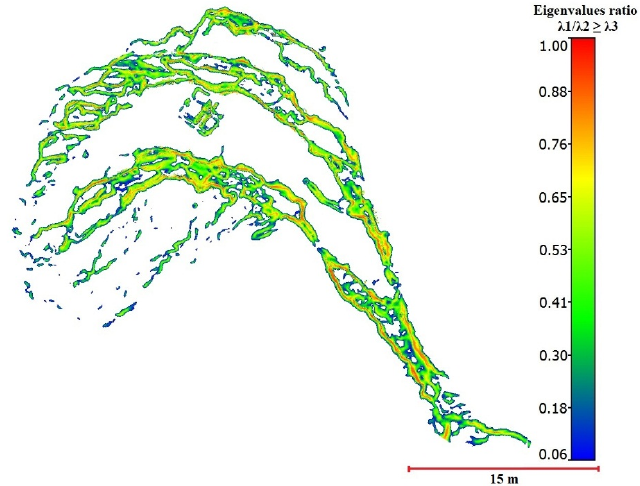
Figure 15. Extraction of landslide scarp features for the of Salhoub/Al-Juaidieh landslide based on variation in the local topography’s Eigenvalue ratio.